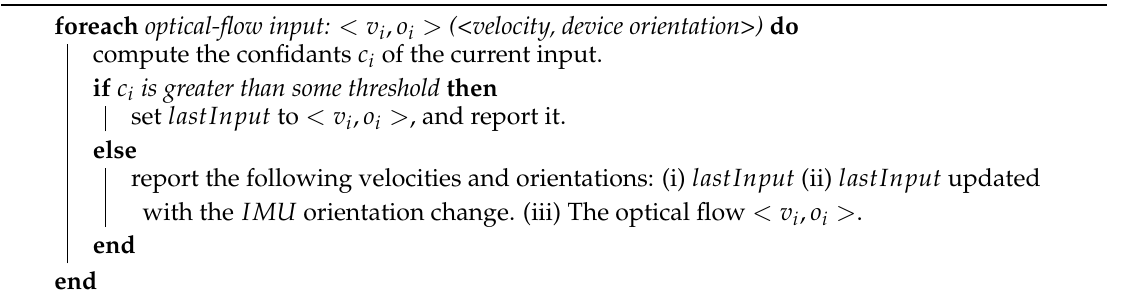
Algorithm 3: Optical Velocity Algorithm: in cases of low confidence it will report several options of velocity and device